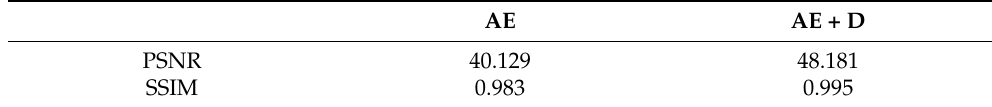
Table 3. Restoration results of different structures.